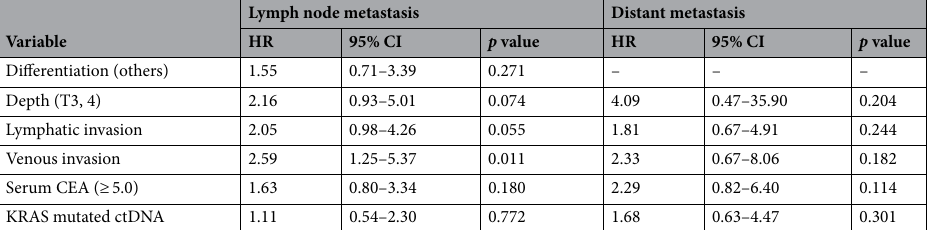
Table 3. Multivariate analysis of lymph node metastasis and distant metastasis. HR hazard ratio; CI confidence interval; others moderately differentiated, poorly differentiated, mucinous and papillary adenocarcinoma; CEA carcinoembryonic